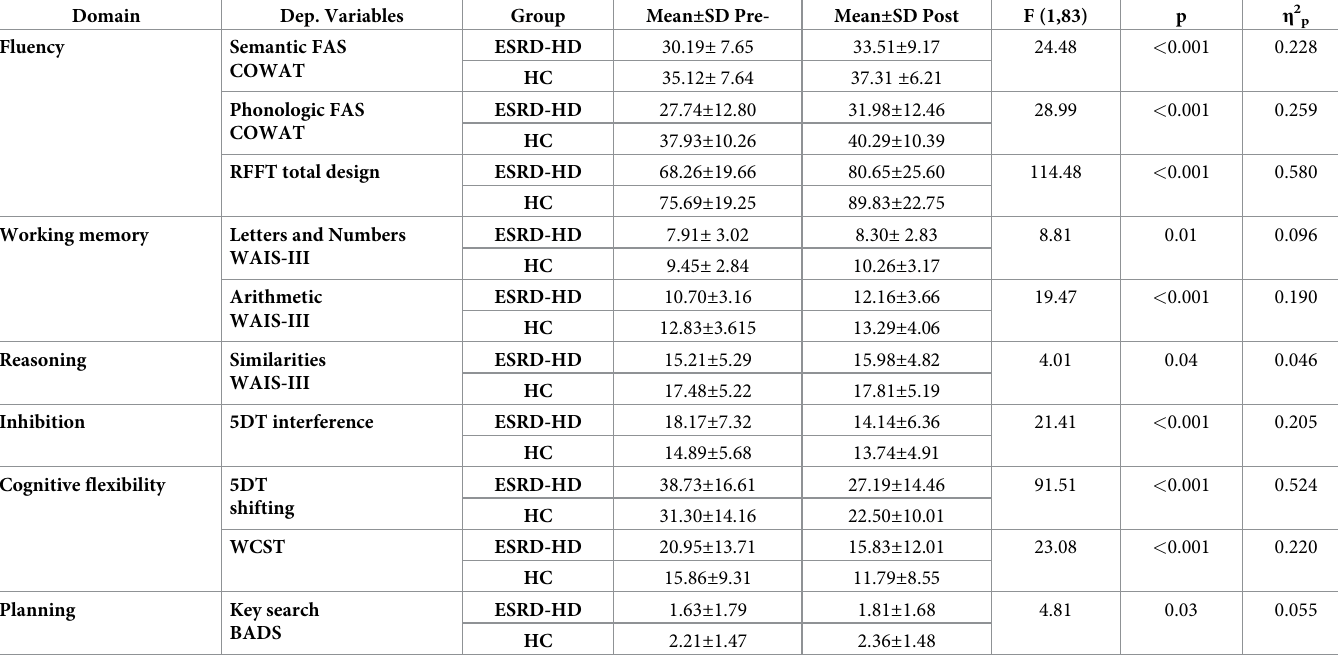
Table 4. Means (±SD) of the pre- and post- cognitive evaluations and statistics for the main repeated measures factor.